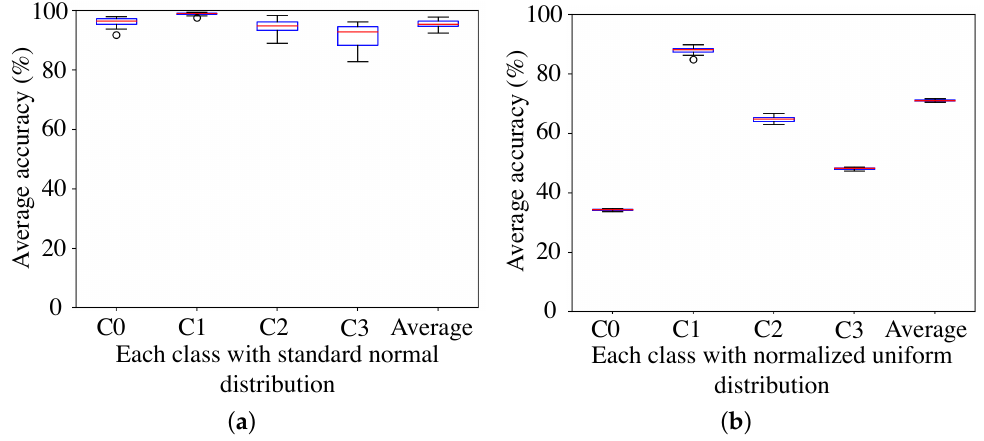
Figure 16. The effect of the distribution used for sampling the input z of the GAN generator: ( a ) standard normal distribution and ( b ) normalized uniform distribution.